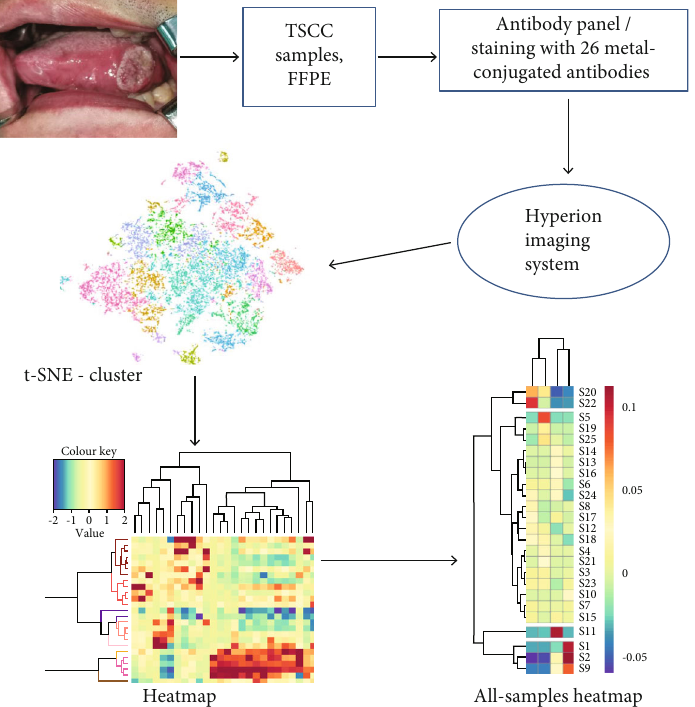
Figure 1: Overall study design. Hyperion imaging system was utilized to detect OSCC tissue samples, and the output data were used for cluster analyses. TSCC: tongue squamous cell carcinoma; FFPE: formalin- fi xed, para ffi